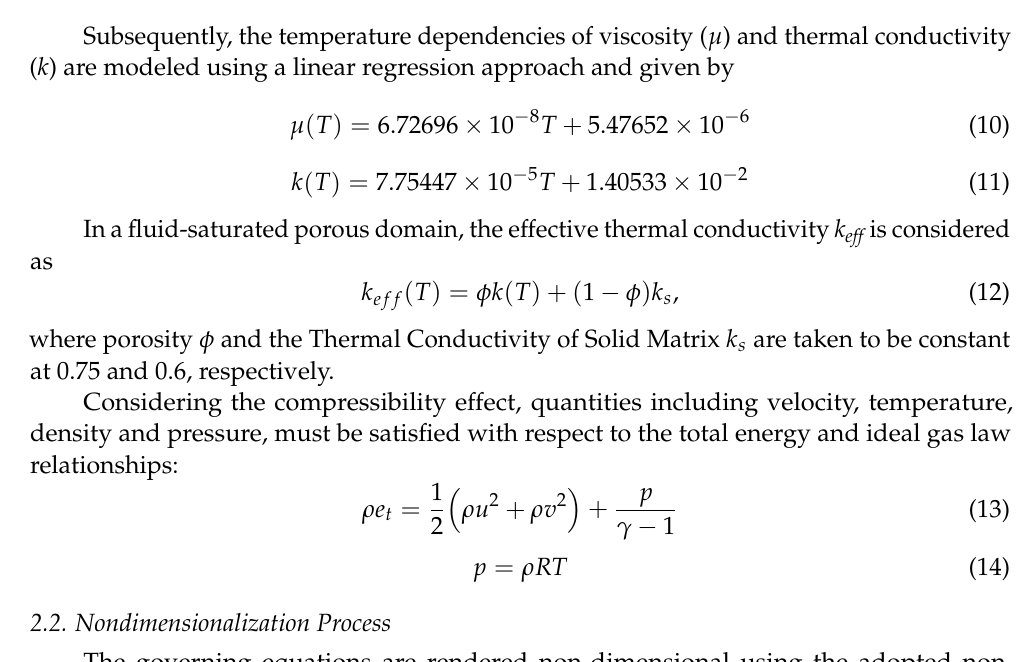
Figure 2. Dynamic viscosity and thermal conductivity of the binary gas mixture as a function of temperature.